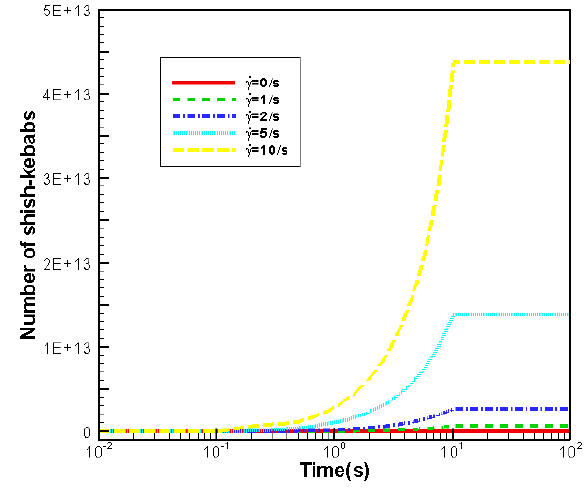
Figure 4. Number of shish-kebabs with different shear rates.